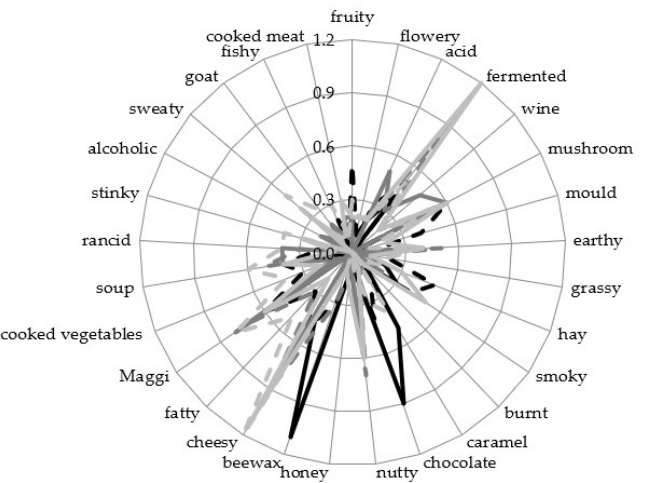
Figure 5. Sensory analysis of the aroma attributes of resulting seasoning sauces. Values of moromi with lupine seeds is shown as black, continuous lines (ML1) and dashed lines (ML2), with wheat as dark grey, continuous lines (MW1) and dashed lines (MW2), and with buckwheat as light grey, continuous lines (MB1) and dashed lines (MB2). Data are presented in a 29-point hedonic scale.